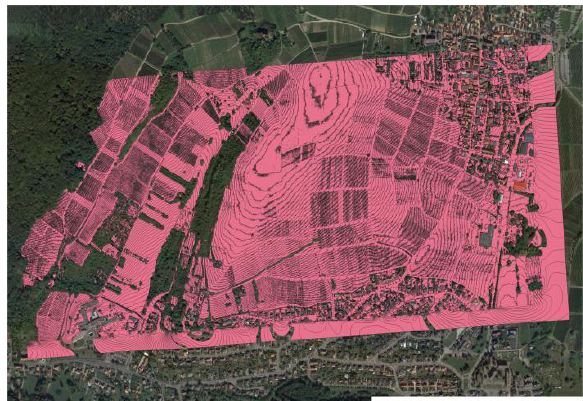
For further processing, the result obtained from the DTM filter was smoothed and converted to vector geometries. The eleva- tion information was preserved. This height information was used to cut out non-bare-ground-information. The integration of additional filter algorithms as size and curvature have been applied to generate a 3-angulated network which itself enabled the extraction of contour lines as shown in Figure 7.